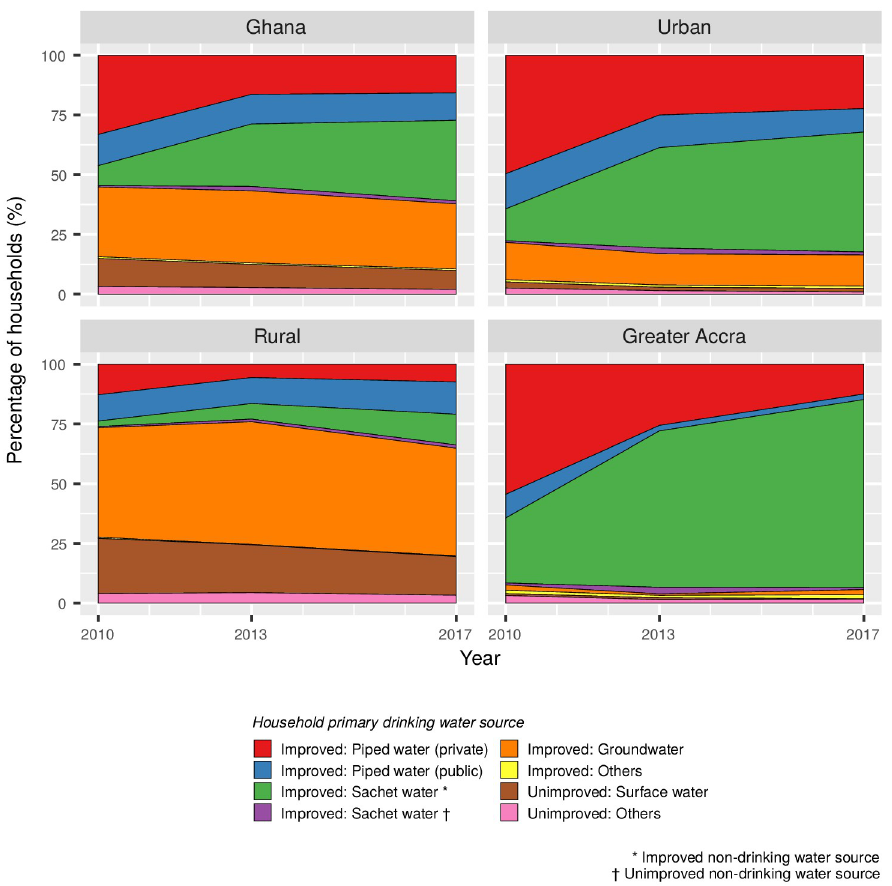
Fig 2. Primary drinking water source for households in Ghana as a percentage of the total number of